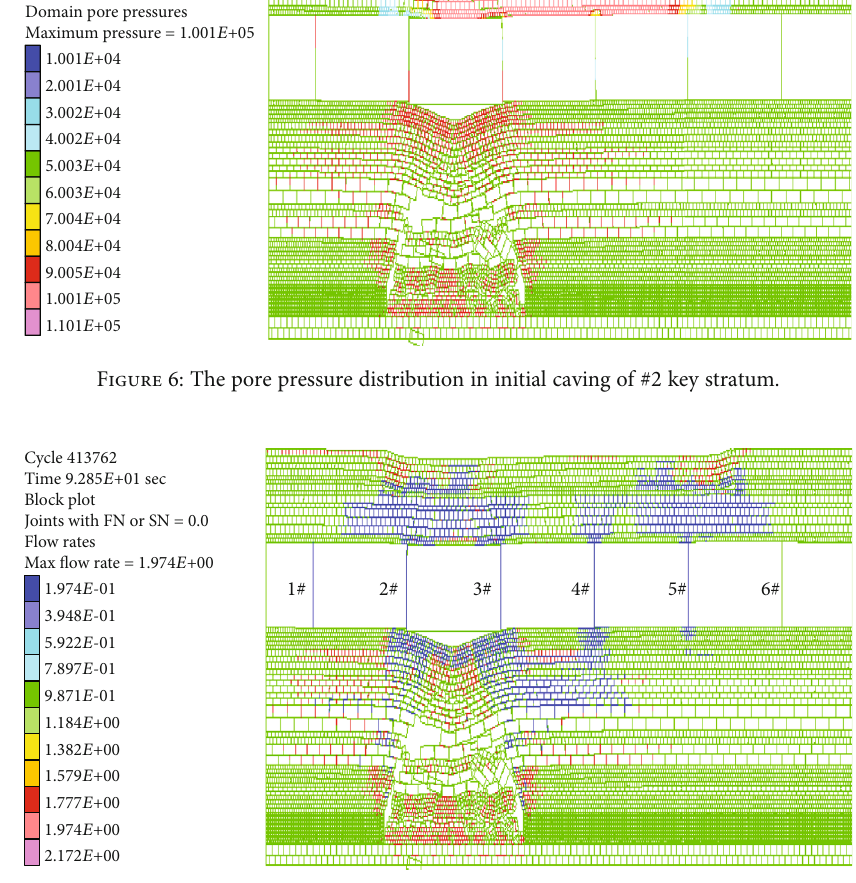
Figure 7: The fl ow distribution in initial caving of #2 key stratum.